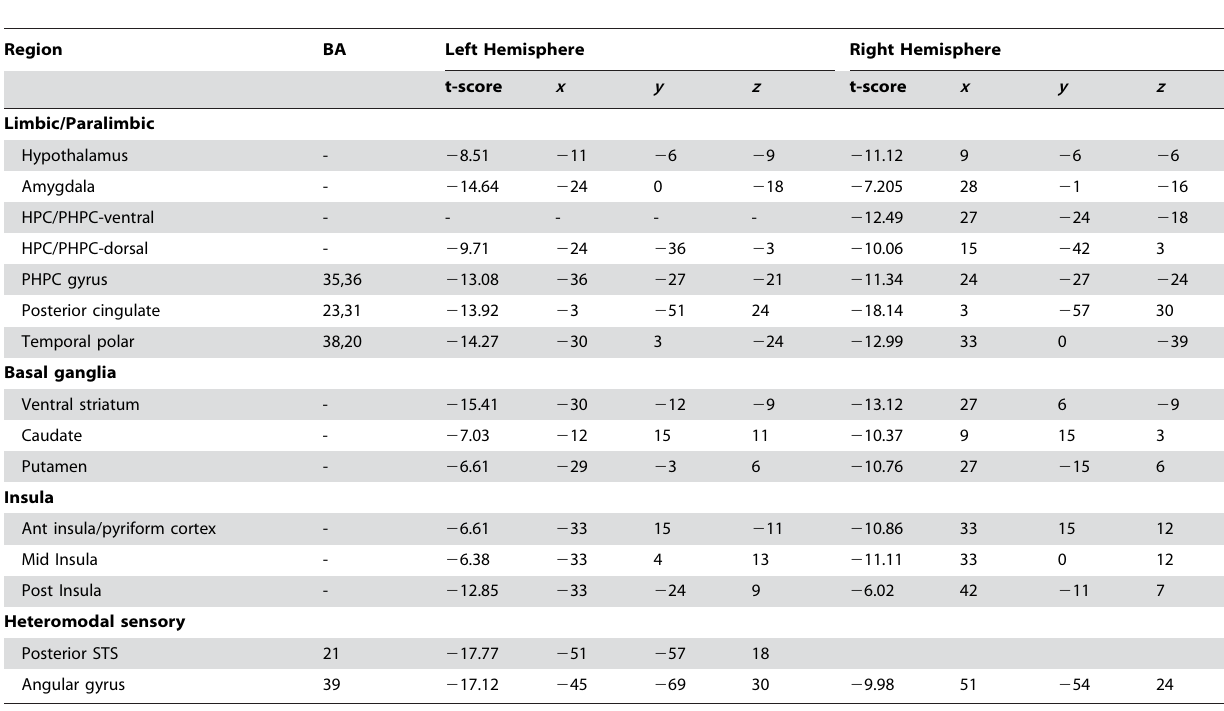
Table 4. Local minima of brain deactivations within limbic, basal ganglia, insula, and heteromodal sensory regions during